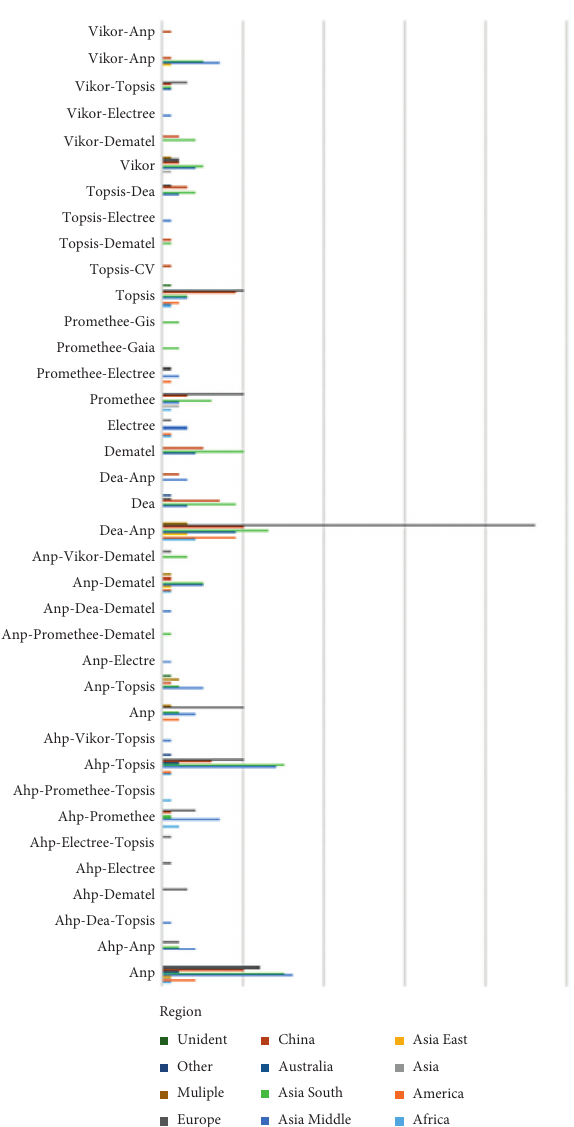
Figure 7: Crosstabulation by region and specific